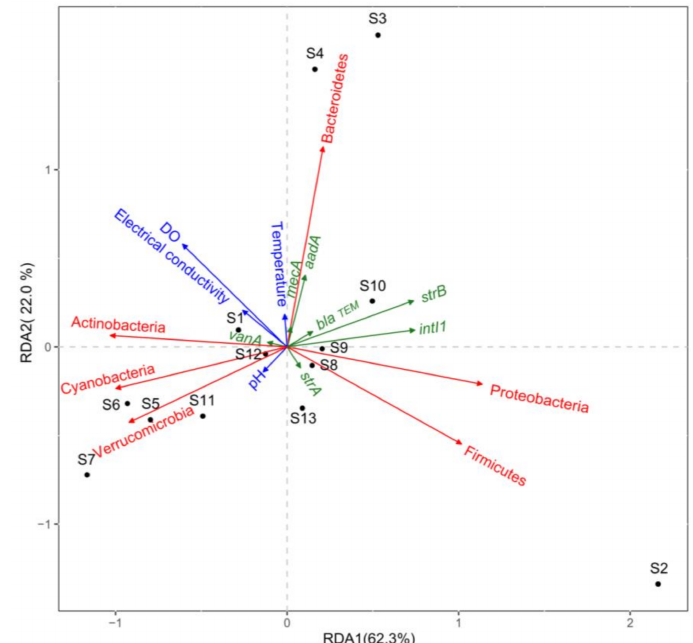
Figure 5. Redundancy analysis of the relationships between environmental factors (blue arrows), main bacterial phyla (red arrows), and ARGs and intI1 genes (green arrows).